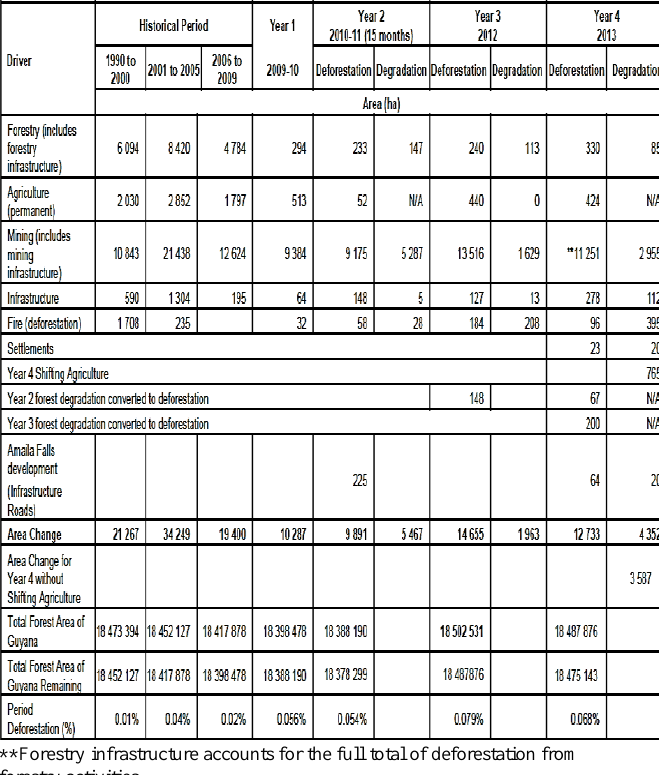
Table 1: Forest change area by period and driver from 1990 to